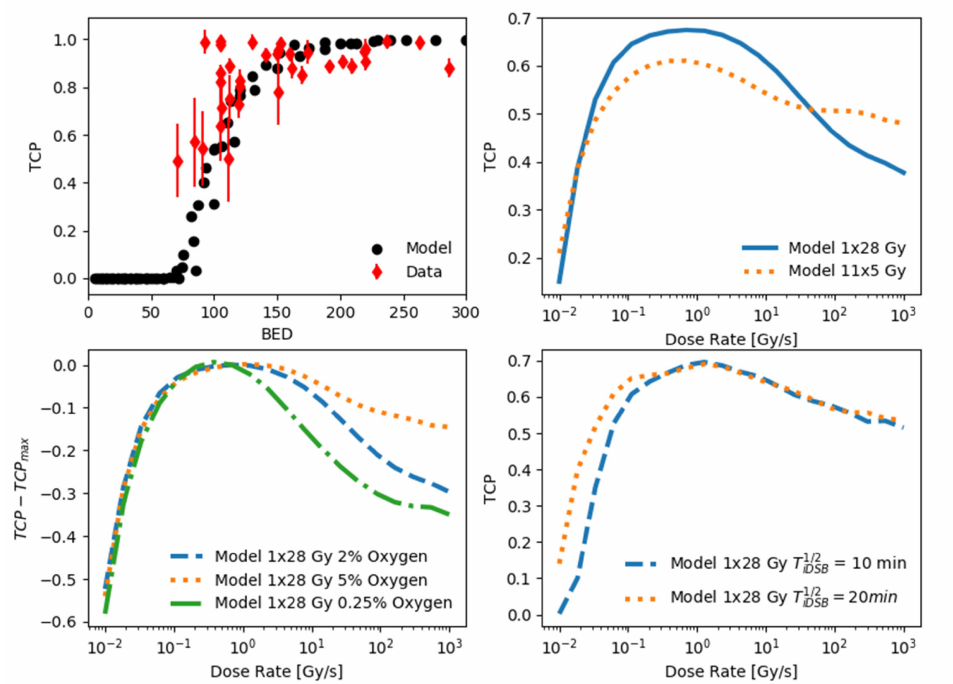
Figure 4. Potential reduction of tumor control probability (TCP) at uHDR. ( top left ): TCP data based on 2028 non-small cell lung cancer (NSCLC) patients (black circles) treated with different fractionations of stereotactic radiotherapy as a function of biologically equivalent dose (BED) com- piled by Shuryak et al. [29] (red diamonds) with UNIVERSE prediction. ( top right ): UNIVERSE predictions of TCP as a function of the dose-rate for two fractionation schemes with comparable effect at conventional dose-rates (one fraction of 28 Gy, blue line; eleven fractions of 5 Gy, dotted orange line). Both approaches exhibit a considerable loss of TCP towards uHDR, with a larger reduction predicted for the single fraction approach. ( bottom left ): The predicted decline of TCP from its maximum value is dependent on the assumed oxygen level. Within the range of typical values of oxygen concentrations in tumors (0.25% shown as green dash-dotted line to 5% shown as orange dotted line [32,33]), the potential loss increases towards lower oxygen concentrations. ( bottom right ): Observation of a sparing effect can also be influenced by the effect at the conventional reference dose rate. Depending on the assumed DNA repair half-life times ( T 1/2 ) and the reference dose-rate iDSB iso-effectiveness or even increased effectiveness at uHDR could be